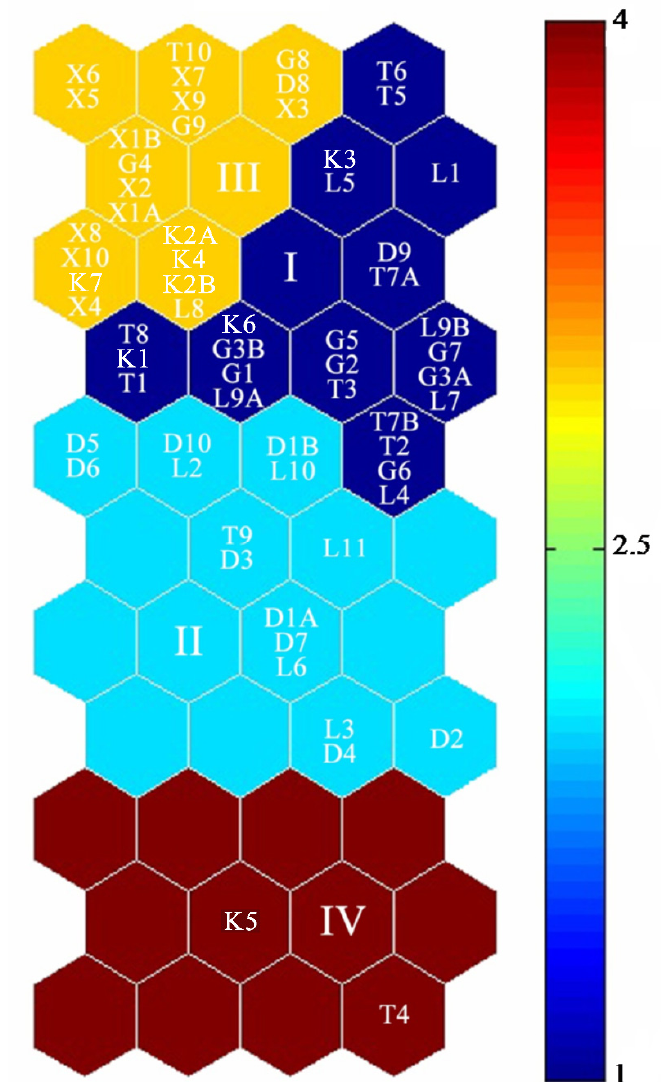
Figure 5. Spatial heterogeneity of trace elements in each sampling point based on SOM. Note: T 1 –T 10 represents 10 sampling points of Toson Lake; G 1 –G 9 represents 9 sampling points of Gahai Lake; D 1 –D 10 represents 10 sampling points of Dasugan Lake; K 1 –K 7 represents 7 sampling points of Kreuk Lake; X 1 –X 10 represents 10 sampling points of Xiaoqaidam Lake; L 1 –L 11 represents 11 sampling points of Xiligou Lake.